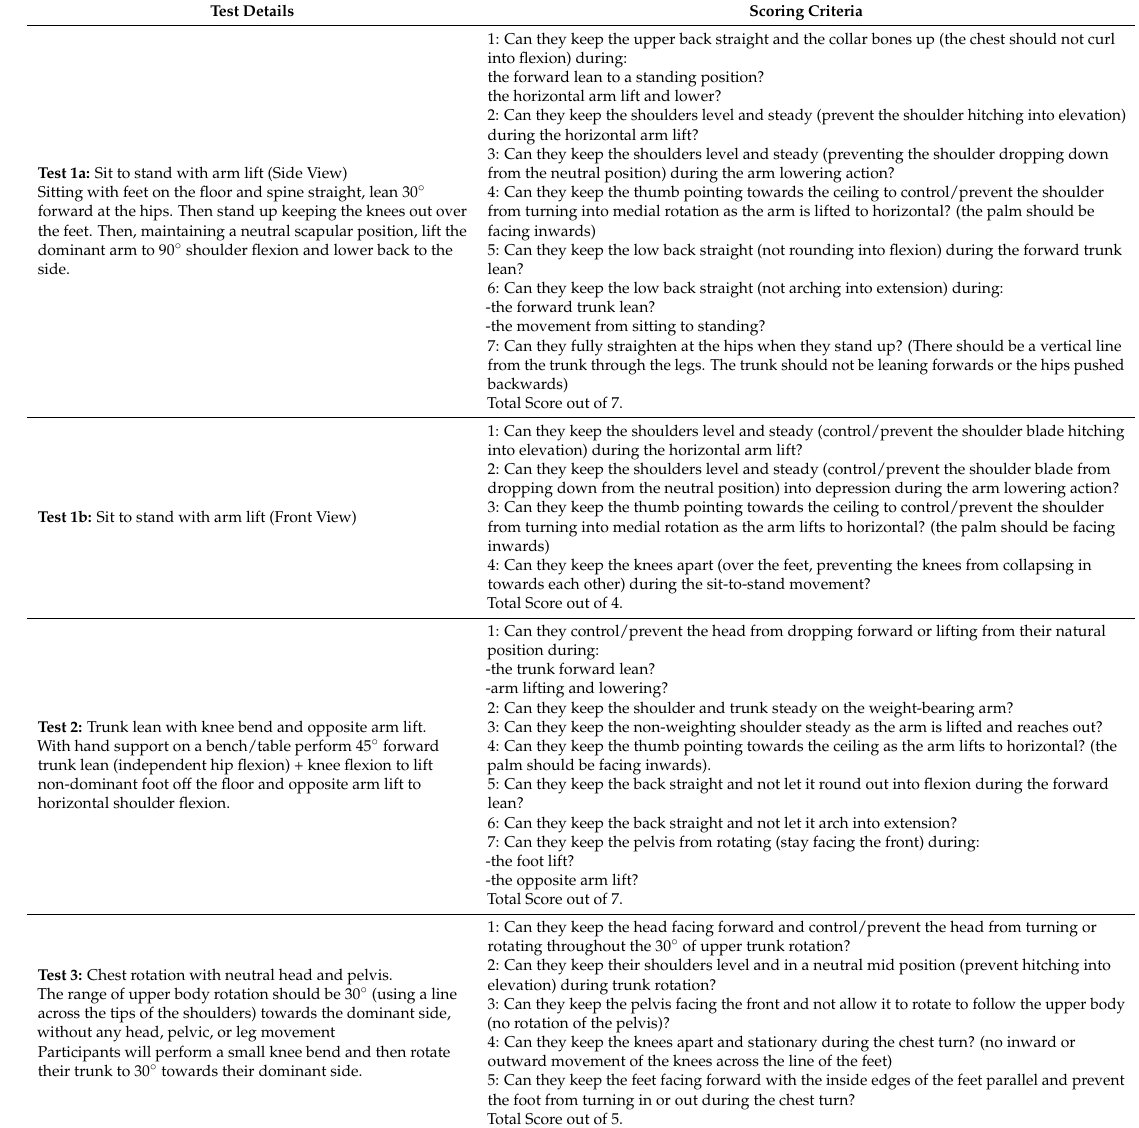
Table A1. Movement Screen Test Instructions and Scoring